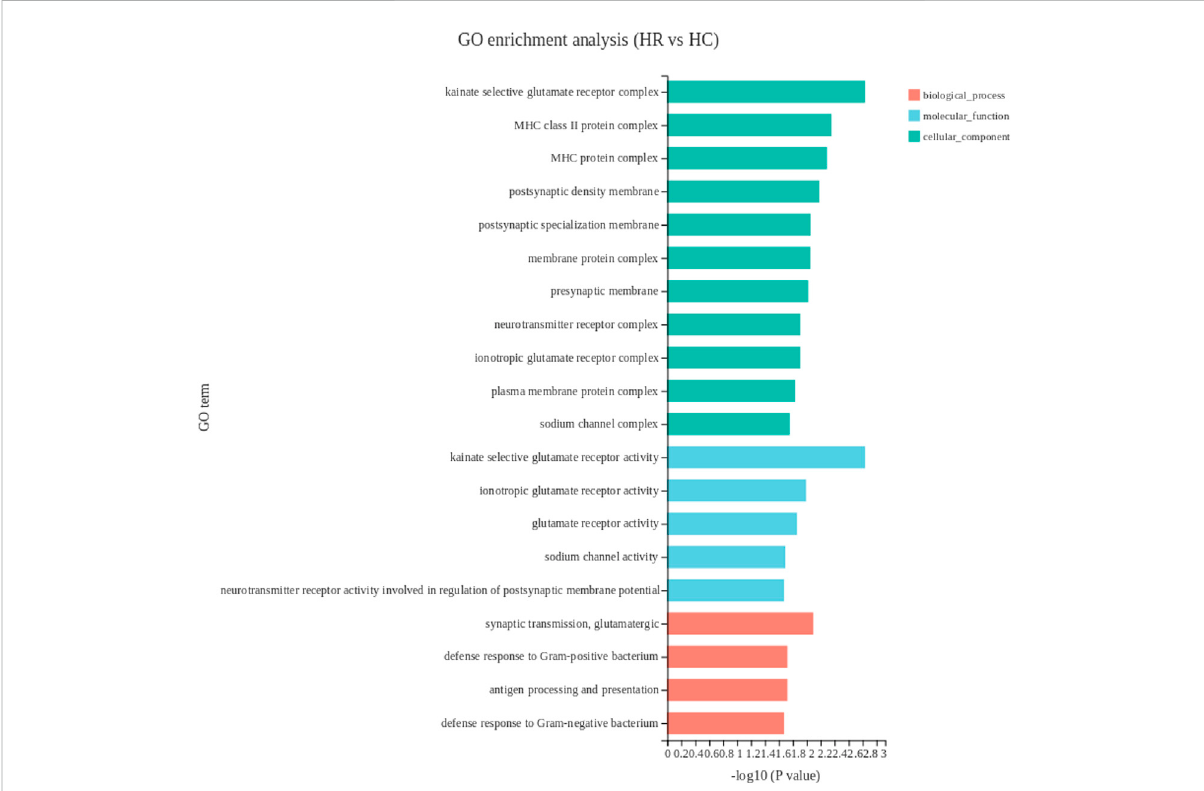
FIGURE 5 The top 20 enriched gene ontology terms of DEGs in hypothalamus. The X -axis shows the signi fi cance level of the enrichment, corresponding to the height of the column, where the smaller the FDR and the greater the -log10 ( p -value) value, the more signi fi cantly enriched the GO term; the Y -axis shows the SDEG-enriched GO term. HR, hypothalamus of rooster; HC, hypothalamus of